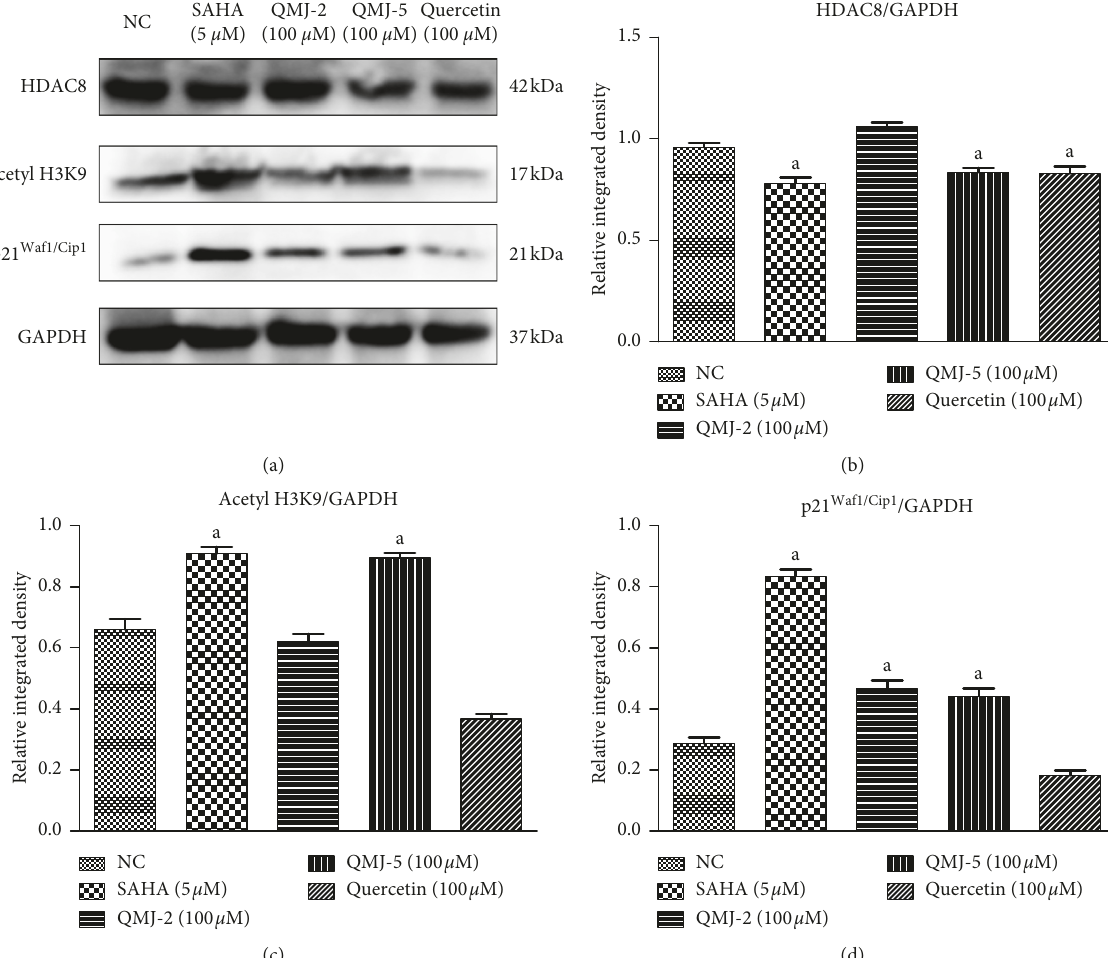
Figure 2: Effect of various compounds incubated for 24h on HDAC8, acetyl histone H3K9, and p21 Waf1/Cip1 protein expression in HCT116 cells. All values are expressed as mean ± SEM of three experiments. a p < 0 . 05 vs. normal control